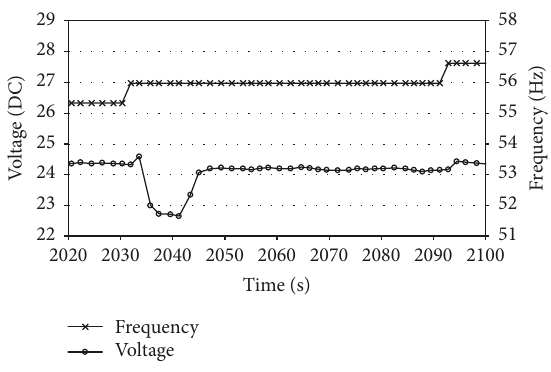
Figure 9: System adjustment as the frequency increases by 1.5 Hz.